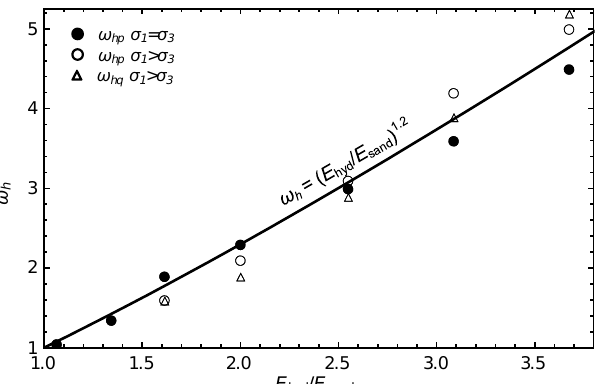
Figure 10. Fitted value of ω hp and ω hq as a function of the stiffness ratio (circles = spherical relaxation of DEM; triangles = deviatoric relaxation of DEM; filled and hollow markers represent samples isotropically and deviatorically loaded, respectively; line = power-law fit for ω h